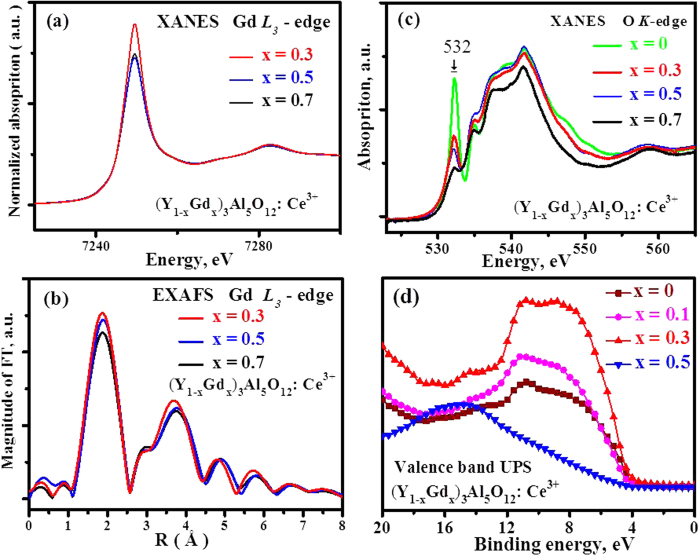
(a) The Gd L3-edge XANES, (b) the Fourier transformation EXAFS spectra in R space, (c) the O K-edge XANES spectra, and (d) the valence band spectra of (Y1−xGdx)3Al5O12: Ce3+.